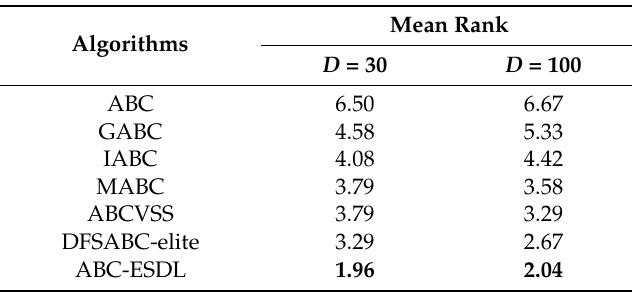
Table 4. Mean ranks achieved by the Friedman test for D = 30 and 100.